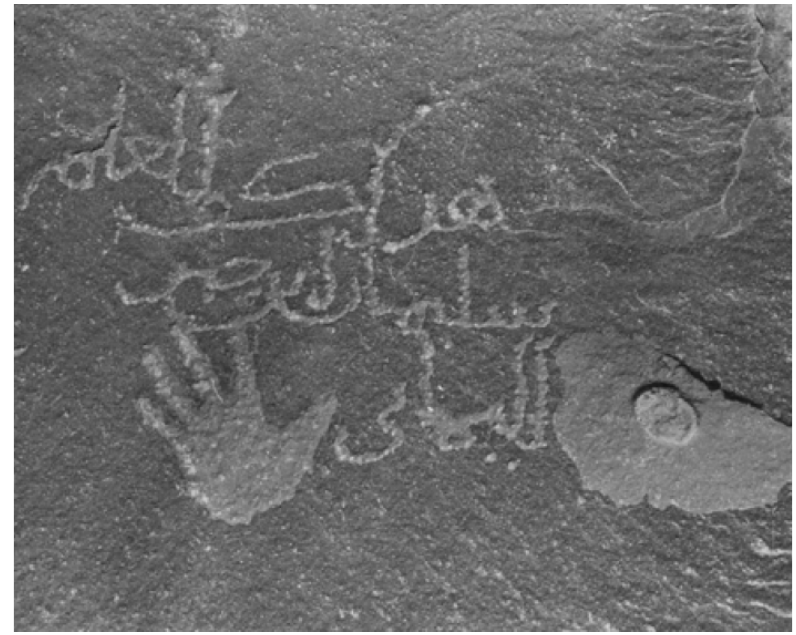
Figure 26. Hand associated with Arabic inscription that says “this is the hand of Sulaiman